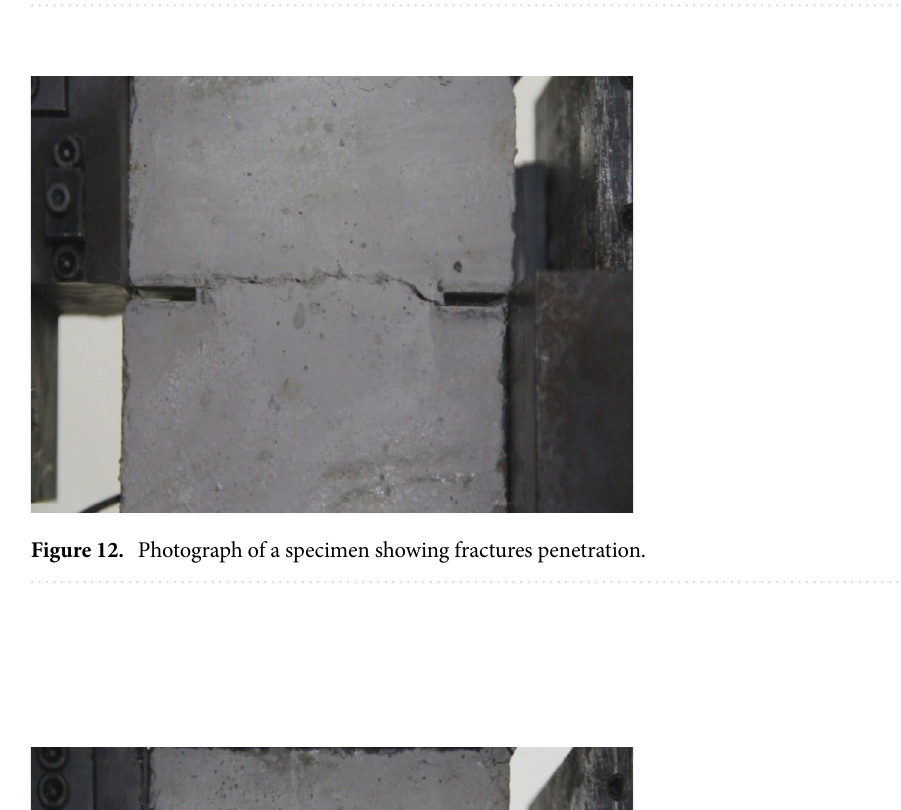
Figure 11. Photograph of a specimen showing fractures appearing.